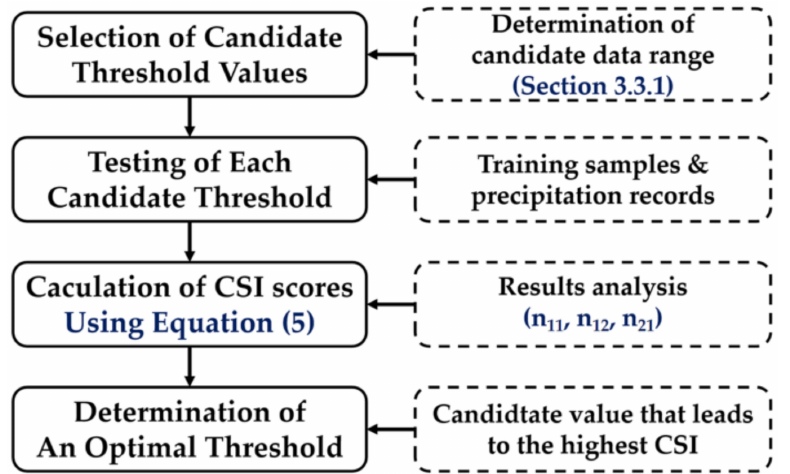
Figure 1. Flowchart for the procedure of determining threshold value based on the critical success index